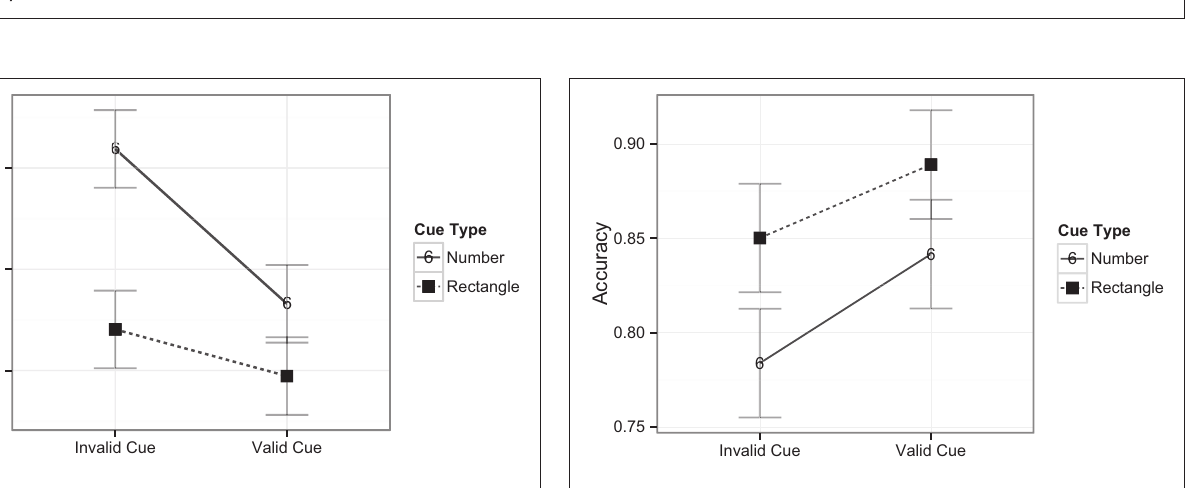
FIGURE 5 | Interaction between target position, cue position in temporal stream, and cue type. Graph (A) shows trials with number cues, whereas Graph (B) shows those with letter cues.